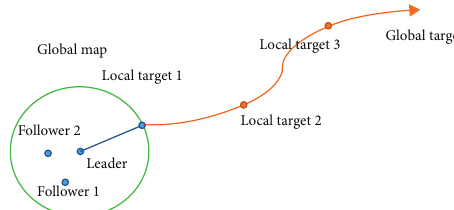
Figure 2: The intersection of global path planner and local path planner.